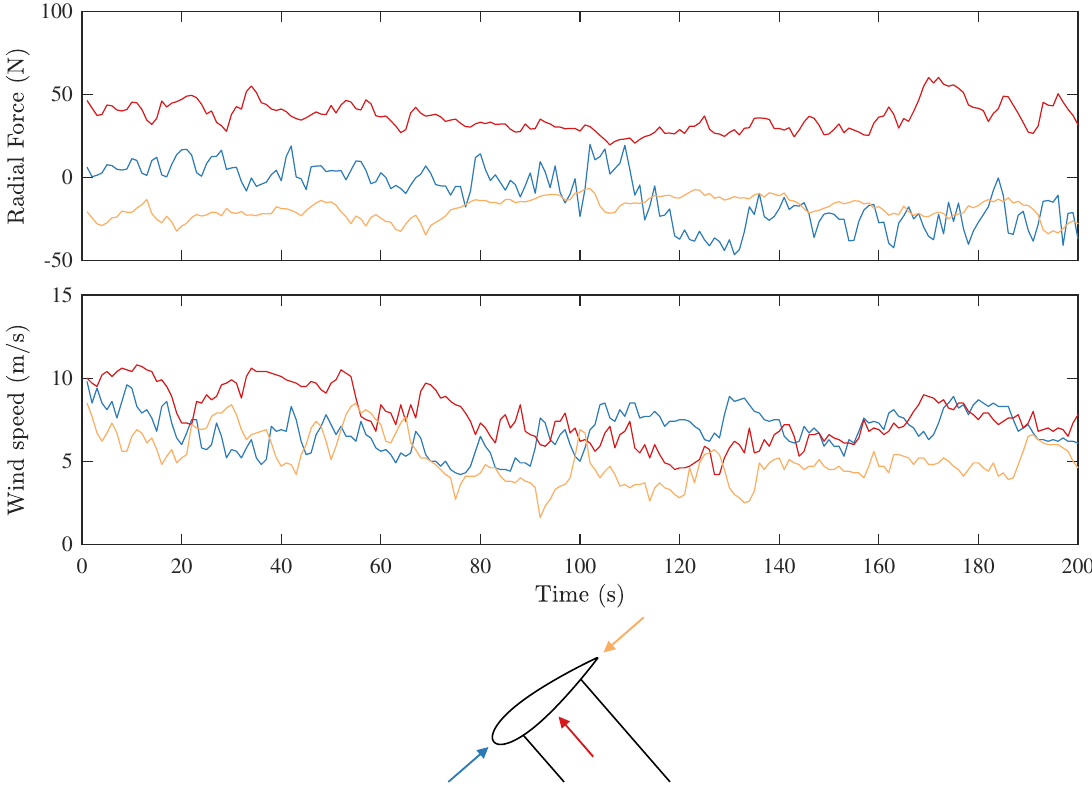
Figure 11. Measured forces with the turbine mechanically fixed for three different wind directions, relative to the blade. Top : the radial force. Bottom : the corresponding wind speed.